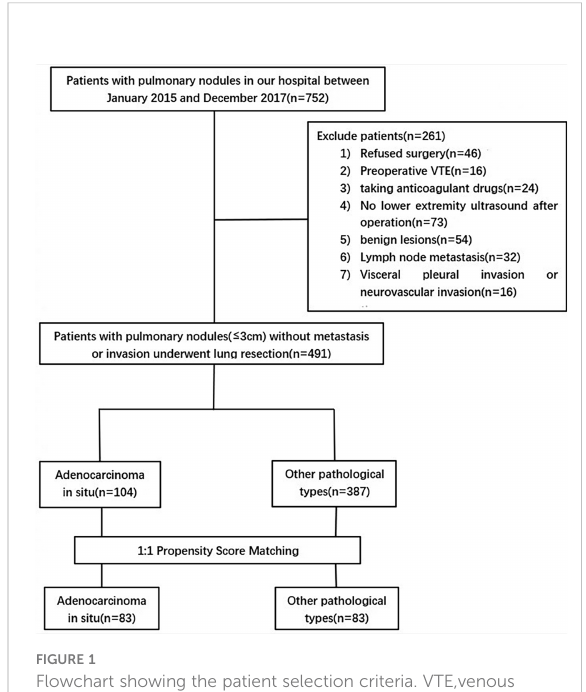
FIGURE 1 Flowchart showing the patient selection criteria. VTE,venous